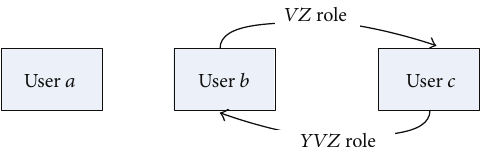
Figure 9: Social network created from FPSN presented in Figure